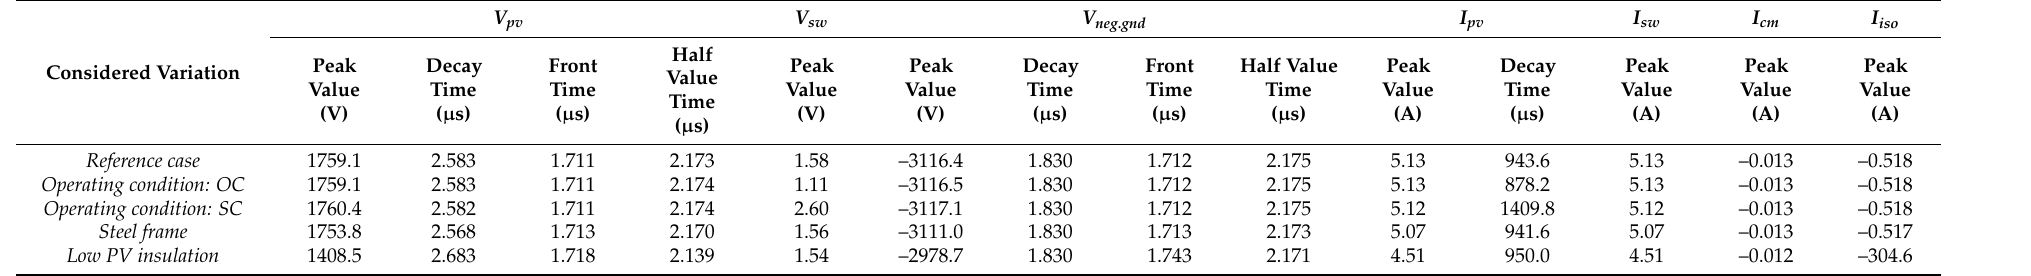
Table 6. Sensitivity analysis on voltages and currents induced with the parameter change in the PV module model.